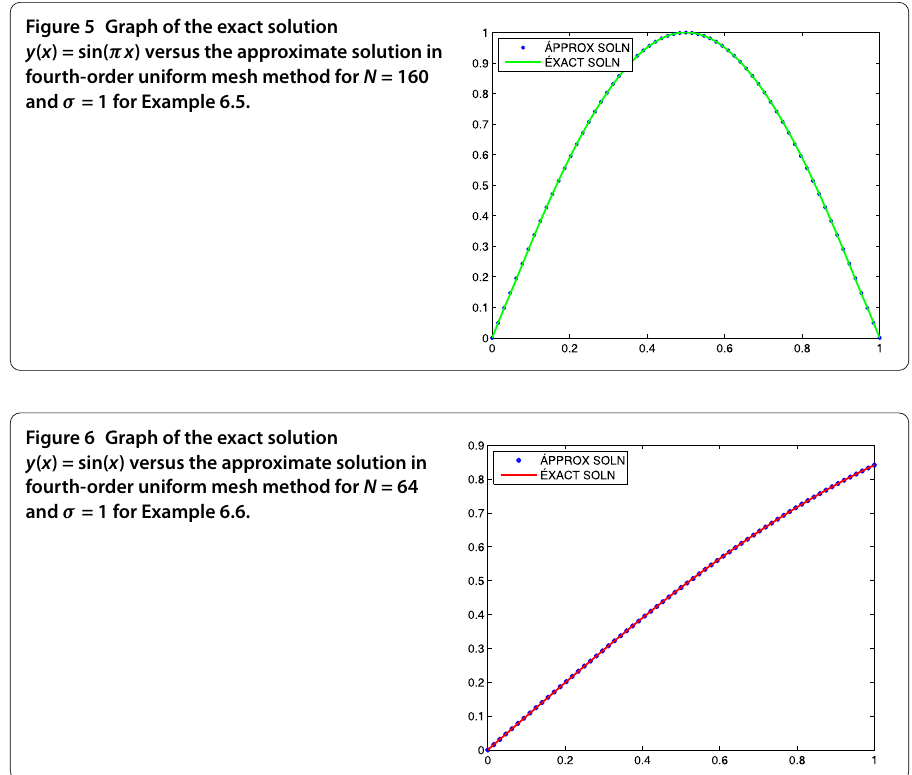
Figure 5 Graph of the exact solution y ( x ) = sin( π x ) versus the approximate solution in fourth-order uniform mesh method for N = 160 and σ = 1 for Example 6.5.